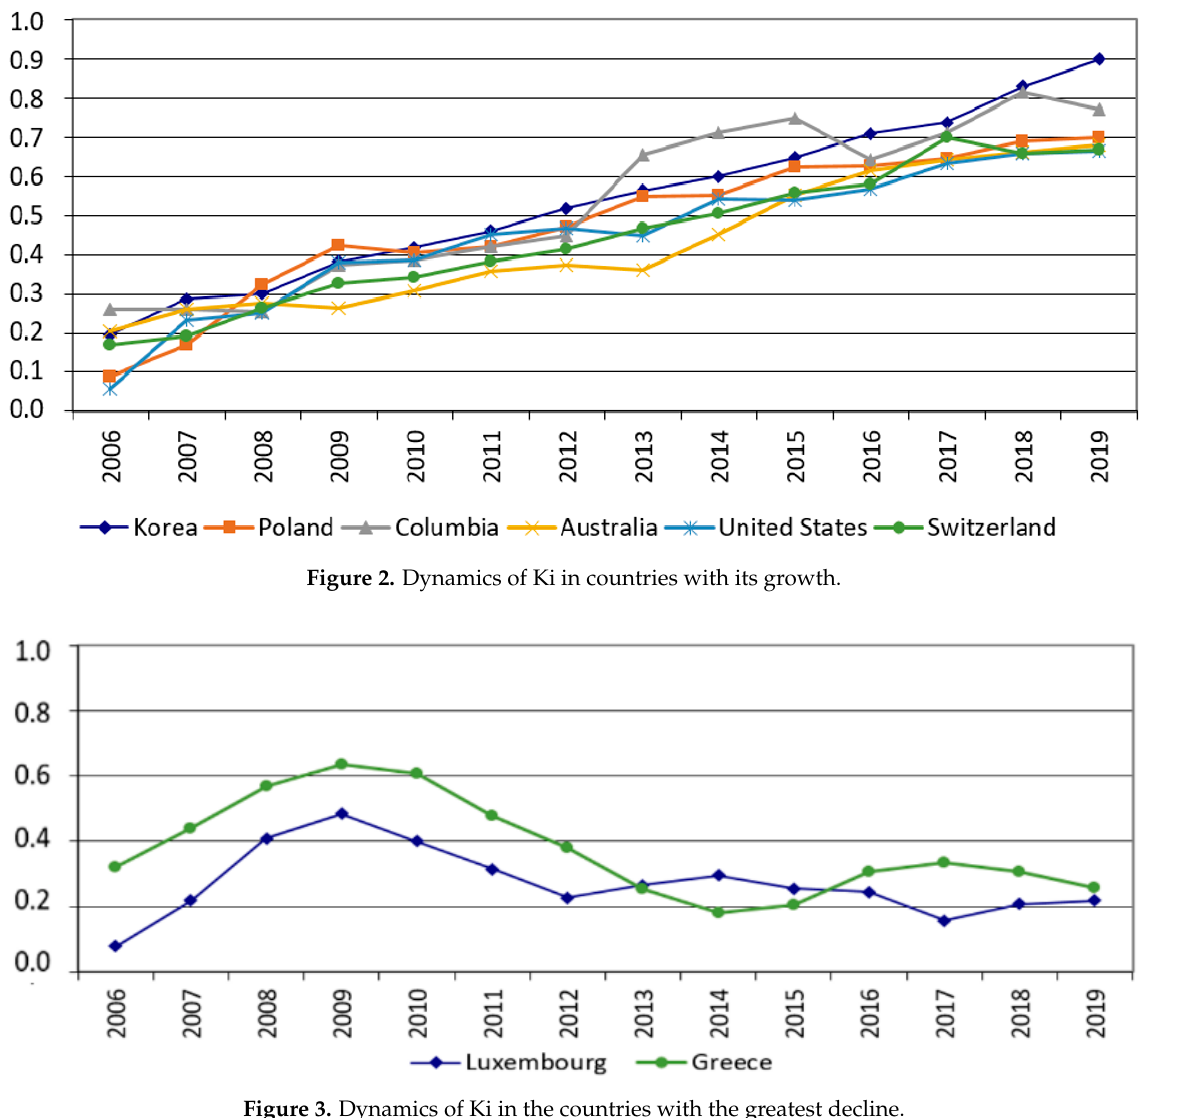
Figure 3. Dynamics of Ki in the countries with the greatest decline.